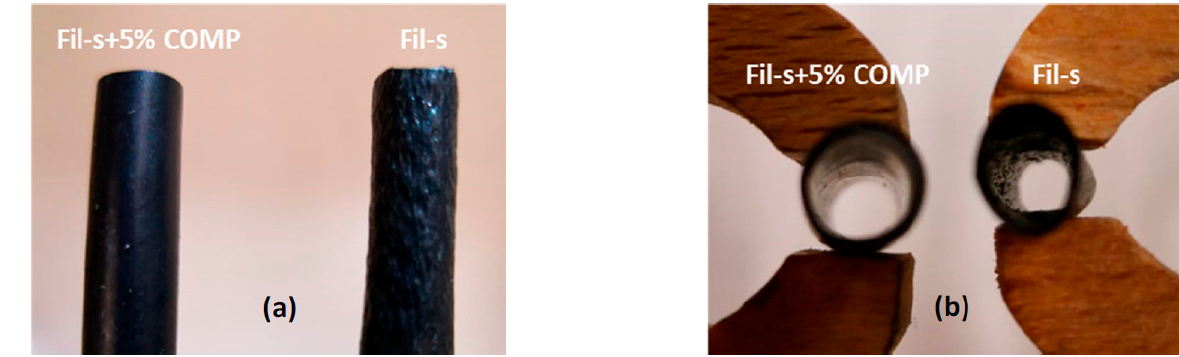
Figure 11. Images of the pipes obtained from Fil-s as such and the compatibilized one: ( a ) the external surface; ( b ) the section.